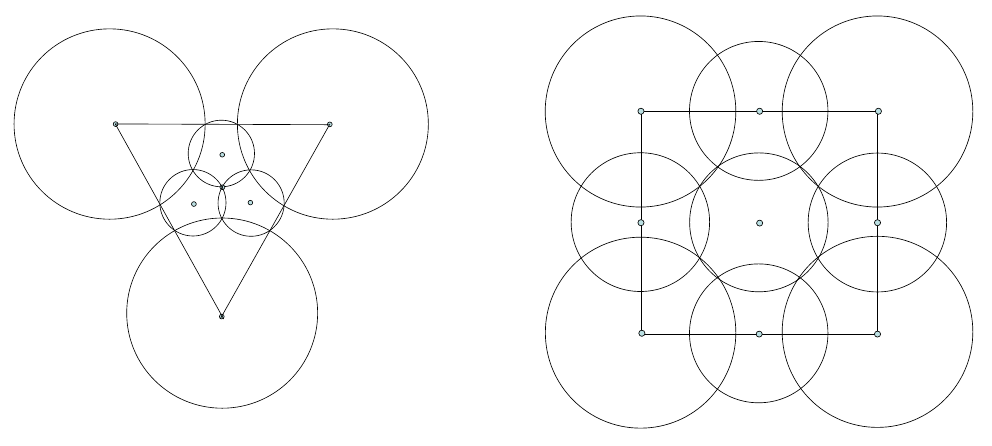
Figure 9. Separation of big disks.